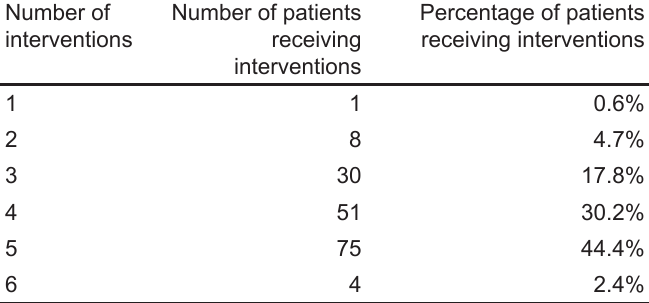
Table 1. Number and percentage of patients receiving